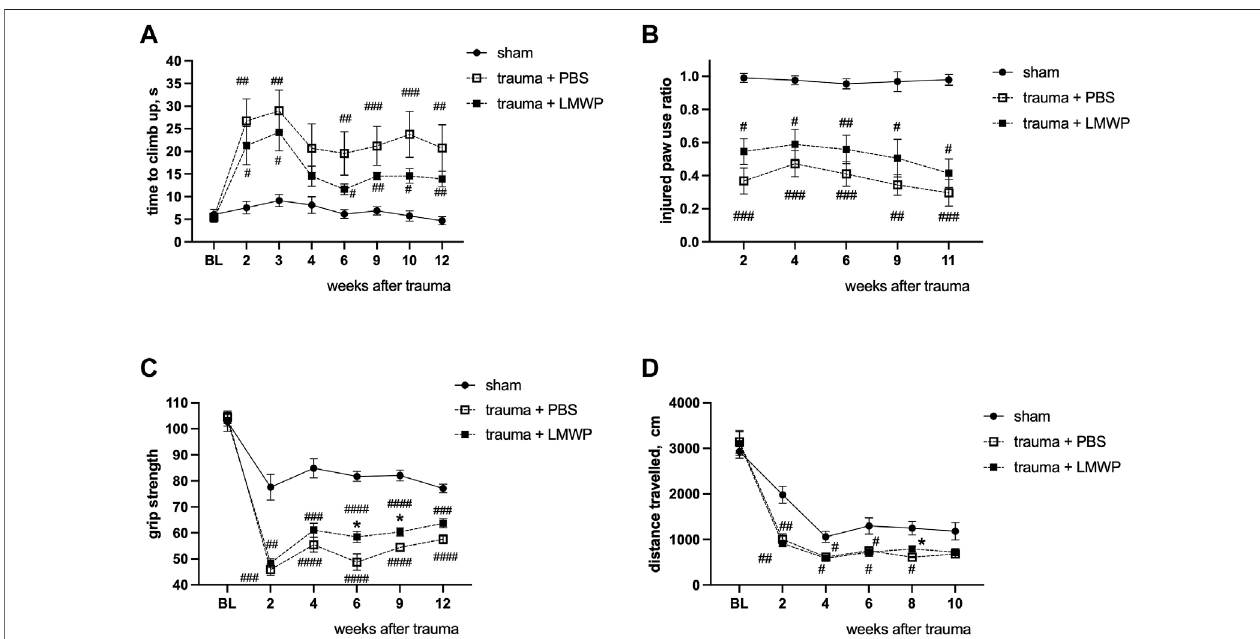
FIGURE10| FunctionaloutcomeofsystemicallydeliveredLMWPinthemousecervicalhemicontusionmodel. (A) Recoveryintheclimbingtestshowedatendency for better recovery in the LMWP group compared to the PBS group. (B) Cylinder test for the assessment of asymmetry of front paw use showed a tendency for better improvement of the LMWP group compared to the PBS group although the difference was not statistically signi fi cant. (A,B) # p < 0.05, ## p < 0.01, ### p < 0.001, #### p < 0.0001Kruskal-WallistestwithDunn ’ spost-hocpair-wisecomparisonvs.shamgroup; n =7 – 13. (C) TheLMWP-treatedanimalsdemonstratesigni fi cantincrease of frontpaw grip strength in comparison with the PBS-treated animals on the weeks 6 and 9 after the trauma induction. (D) LMWP treatment did not affect general locomotor activity in a 15 min test in open fi eld chamber. (C,D) # p < 0.05, ## p < 0.01, ### p < 0.001, #### p < 0.0001 one-way ANOVA with post-hoc Tukey ’ s pair-wise comparison vs. sham group; * p < 0.05, one-way ANOVA with post-hoc Tukey ’ s pair-wise comparison versus trauma + PBS group; n = 7 – 13.